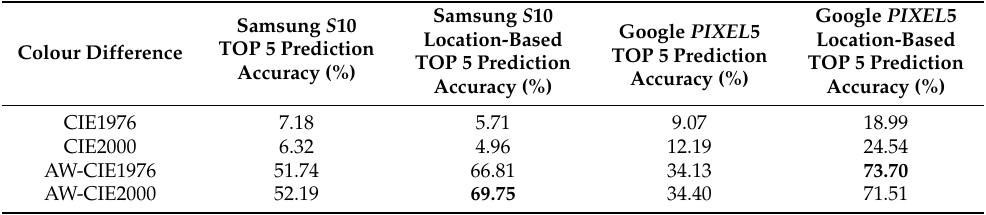
Figure 8. Accuracy curve for top 5 prediction accuracy for Samsung S 10 and Google Pixel 5. Colour models used: RGB and CIELAB; Distance Functions employed: Euclidean distance, CIE1976, CIE2000; LB—Australian Location-Based, AW—added weight. Table 9. Accuracy in percentage in top 5 prediction for both Samsung S 10 and Google Pixel 5 smart- phones using CIELAB colour model and two distance functions(CIE1976 and CIE2000). Location- Based—Prediction using only prominent soil colours in Australian topsoils. AW—Proposed weight difference from Table